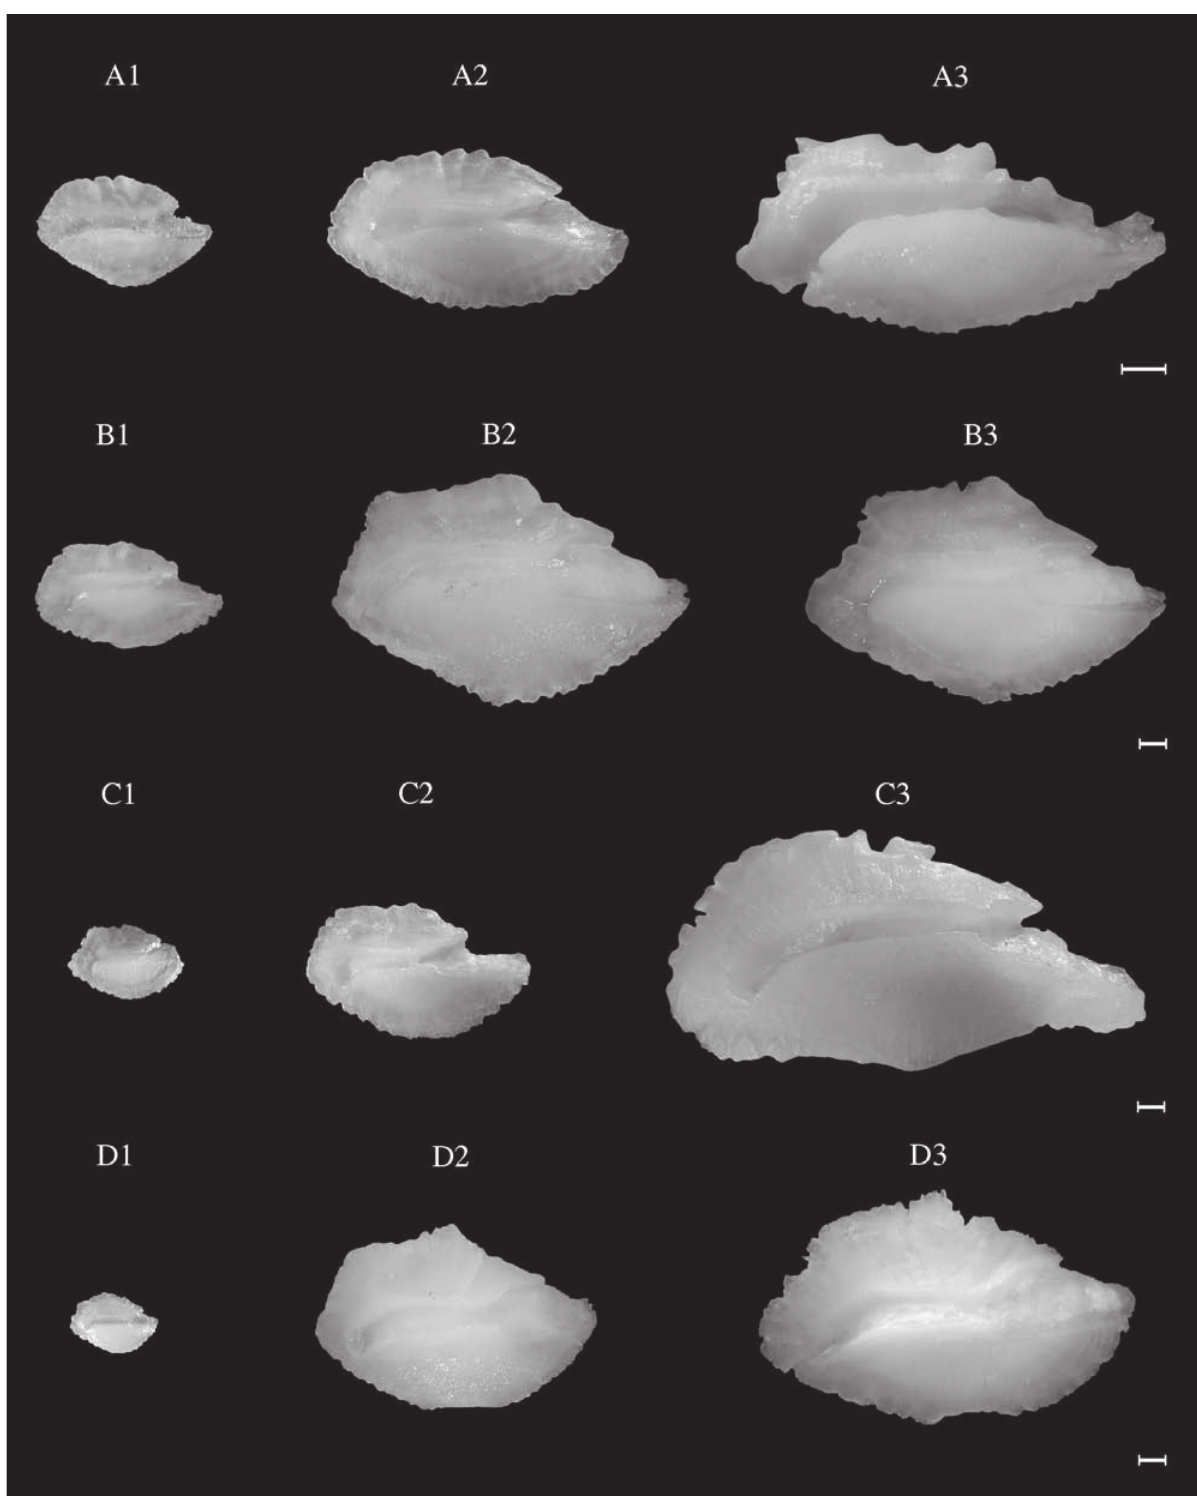
Fig. 60. – Pagellus acarne. TL: A1, 9.0 cm (WM); A2, 17.9 cm (NEA); A3, 26.0 cm (CEA). Pagellus bellottii (CEA). TL: B1, 17.1 cm; B2, 29.2 cm; B3, 29.4 cm. Pagellus bogaraveo . TL: C1, 13.5 cm (WM); C2, 24.2 cm (NEA); C3, 49.2 cm (CEA). Pagellus erythrinus. TL: D1, 6.5 cm (WM); D2, 23.5 cm (CEA); D3, 41.0 cm (WM). Scale bar = 1